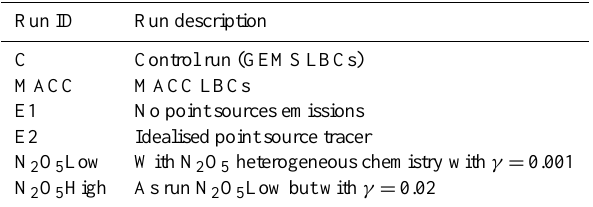
Table 2. List of AQUM runs and experiments. Run